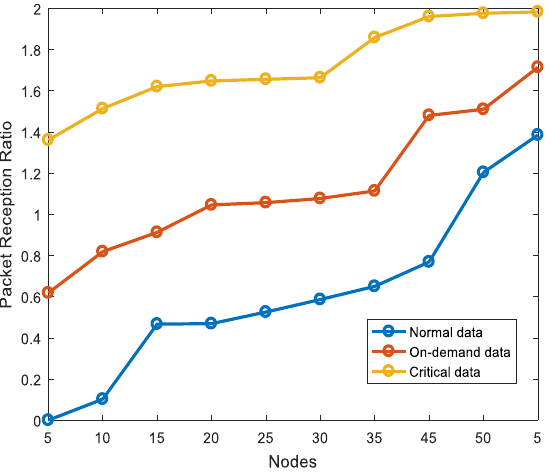
Figure 3. Packet reception ratio.